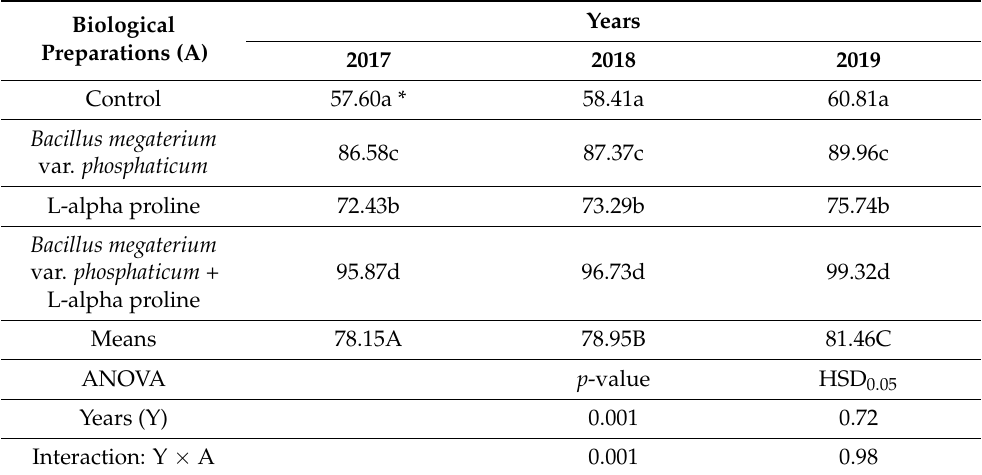
Table 7. Fe content in spring wheat straw, depending on the biological preparations used in 2017–2019, mg kg − 1